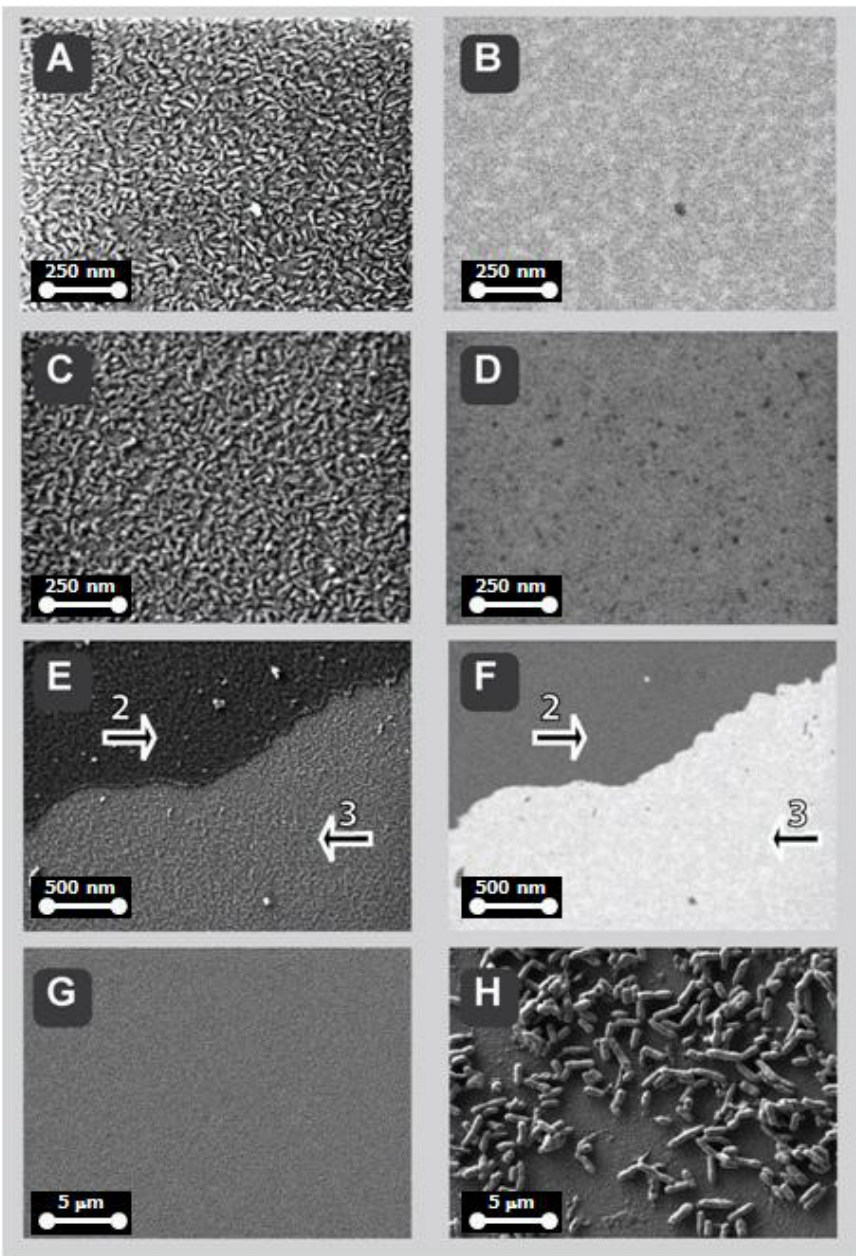
Figure 7. Biofunctionalization of biosensors for binding of bacteria Escherichia coli visualized by scanning electron microscopy, SEM, for titanium-metalized silicon chip. Bare metal ( A , B ), was coated with APTES ( C , D ), then coupled to the antibody ( E , F ) specific for Escherichia coli bacteria. The bacteria binding is shown in ( H ) as a result of specific interaction bacteria Escherichia coli /antibody anti- Escherichia coli , while the negative control ( G ) (non-matched Lactobacillus rhamnosus bacteria/antibody anti- Escherichia coli ) showed no binding. The topography/texture imaging (ET detector) was (pixel-to-pixel) correlated to chemical contrast (EsB detector), shown in image pairs A <=> B, C <=> D, and E <=> F. The low voltage mode of SEM allowed imaging of whole workflow stages from bare metal to completely functionalized sensor with bound bacteria, with no coating, due to low landing energies of the incident electron beam (800 eV). Real-time energy separation of back-scattered electrons allows chemical contrast to be generated; EsB detector grid in images ( B , D , and F ) set to—600 V to enrich single inelastic interaction-electrons characterized by low energy loss, LL-BSE, as described previously